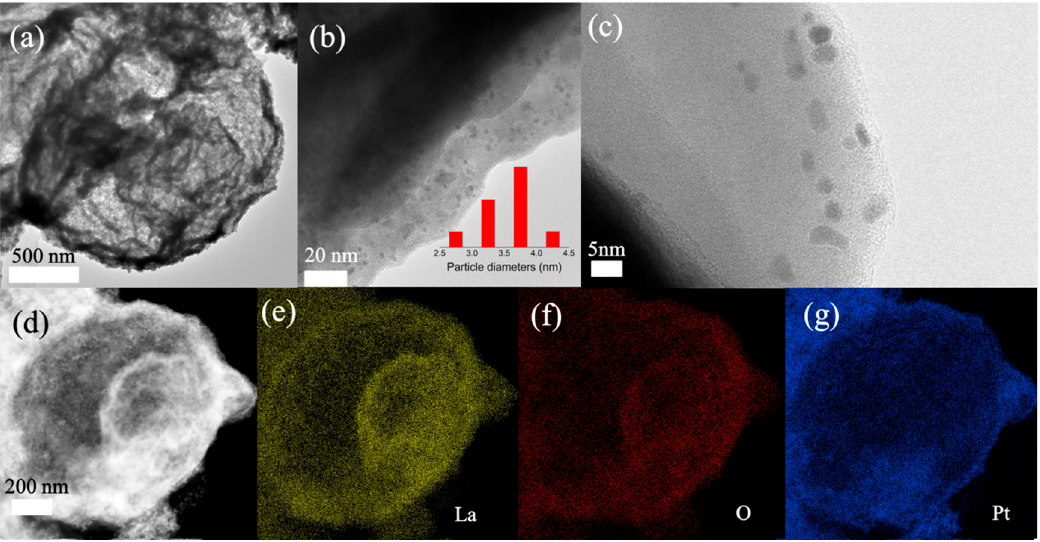
Figure 1. ( a ) TEM and ( b , c ) High-resolution TEM images of S1. ( d ) HAADF-STEM images of S2 and corresponding EDS elemental mapping images of ( e ) La, ( f ) O and ( g ) Pt.